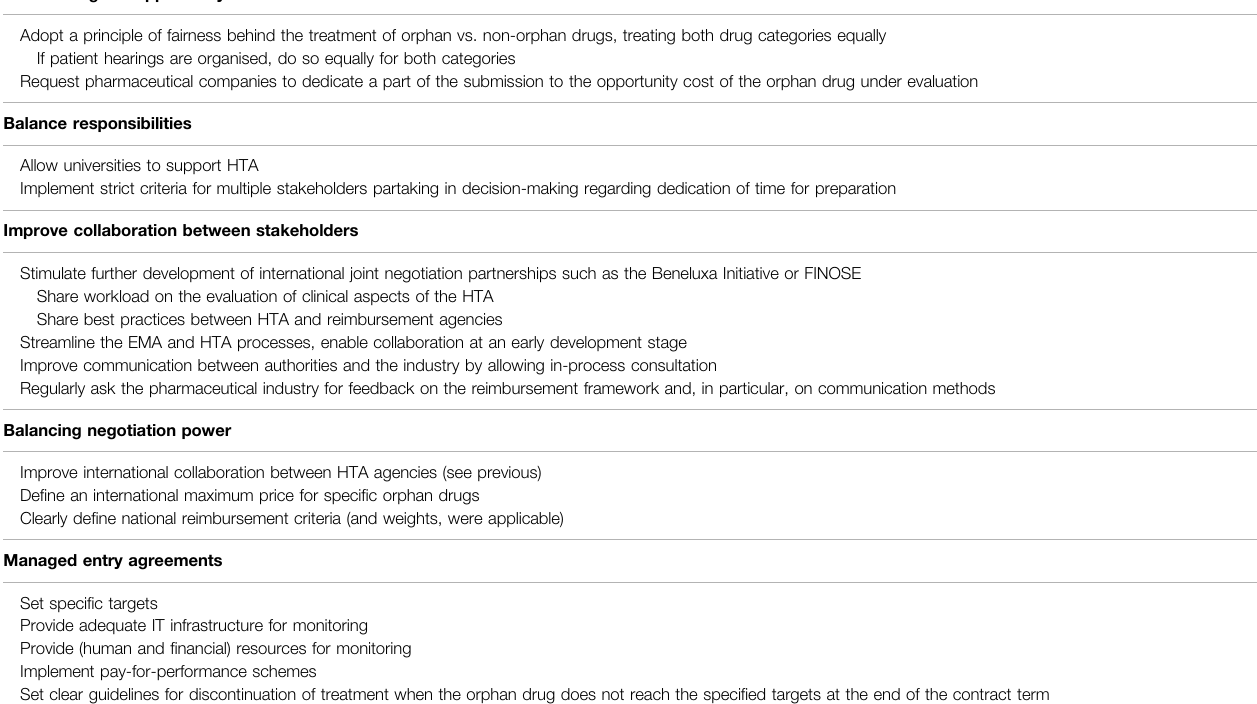
Abbreviations: EMA, European Medicines Agency; EQ-5D, EuroQol 5D; HTA, health technology assessment; ICER, incremental cost-effectiveness threshold; MCDA, multi-criteria decision analysis; QALY, quality-adjusted life year.